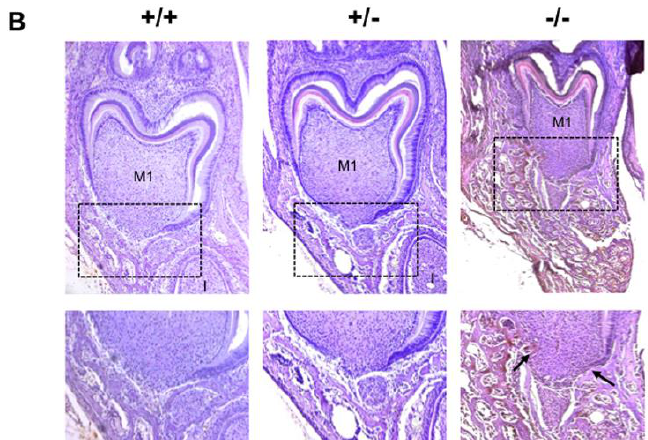
Figure 4. Proliferating cell nuclear antigen (PCNA) and P21 expression patterns in the mandible first molar of 5-day-old Rankl +/+ , Rankl +/- and Rankl -/- C57BL/6 mice. Immunohistochemistry experiments were carried out on 5-µm-thick frontal sections of the Rankl +/+ , Rankl +/- and Rankl -/- C57BL/6 mouse heads at the ages of 3, 4, 5, 6 and 7 days postnatal. At least five mice were analyzed for each genotype and at each age. Results obtained with 5-day-old C57BL/6 mice for PCNA (A) and P21 (B) were presented. PCNA expression was detected at similar levels for the Rankl +/+ and Rankl +/- mice in the cells in Hertwig’s epithelial root sheath (arrows) and the cells in the apical papilla. In contrast, in the Rankl -/- mice the PCNA staining was extremely reduced in those cells, but significant in the alveolar bone cells. P21 expression was almost absent in sections of Rankl +/+ and Rankl +/- mice, but was significant for Rankl -/- mice in the cells in Hertwig’s epithelial root sheath (arrows), the apical papilla and the alveolar bone. Black squares correspond to the region enlarged below. Scale 20X/100 µm. M1: first molar. In the Rankl +/+ and Rankl +/- mice, PCNA staining was observed at all ages in HERS cells with a graded decrease in intensity from days 3 to day 7 (Figure 4A and Table 2). Interestingly, the intensity of the staining was globally lower in the Rankl +/- than in the Rankl +/+ mice, in agreement with a haplo- insufficiency effect. Table 2. Evaluation of PCNA labeling intensity in the apical area of the mandible first molar root according to genotype and age. Quantification was made on sections of five different mice for each group (genotype) and each age (all from postnatal days 3 to 7). -: no detection; +: low staining intensity; ++: intermediate staining intensity; +++: high staining intensity. - + ++ +++ PCNA labeling intensity 3 days 1 Rankl +/+